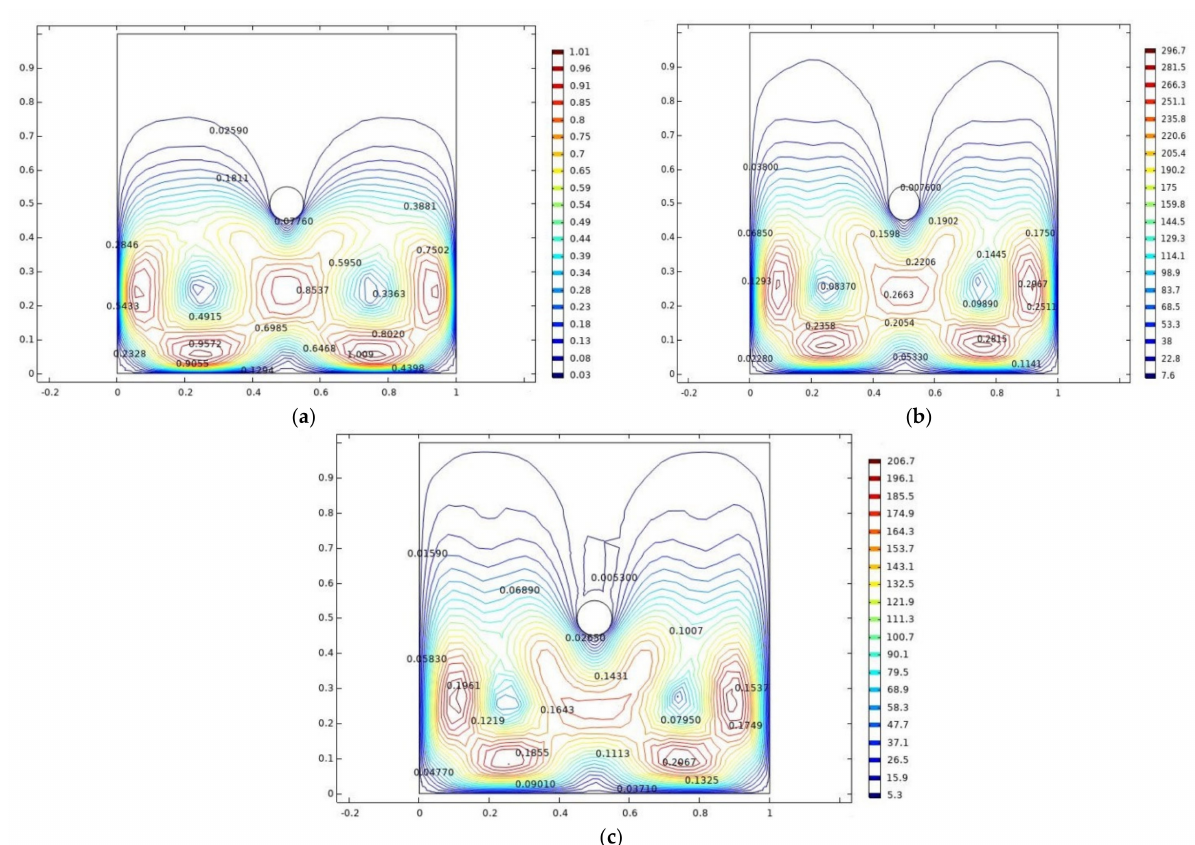
Figure 4. Impact of power-law index ( n ) on velocity contours ( a ) n = 0.5, ( b ) n = 1, ( c ) n = 1.5.